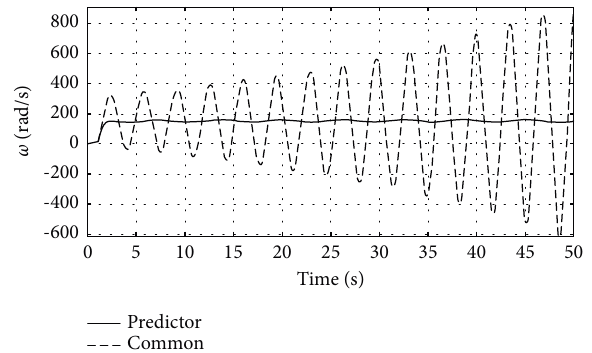
Figure 17: Comparing a predictive-based H controller for τ � 1 . common H ∞